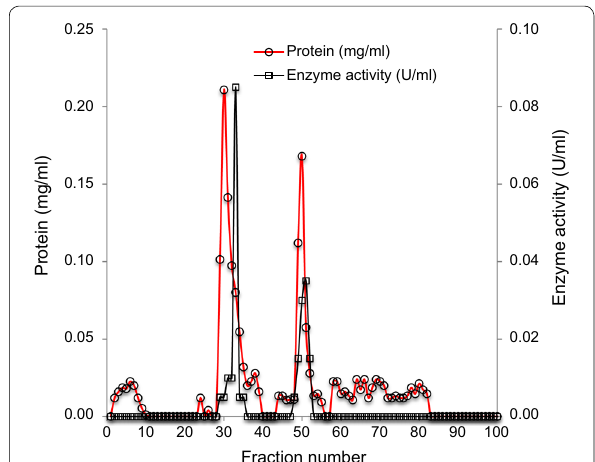
Fig. 1 Elution profile of lignin peroxidase by DEAE-cellulose ion exchange chromatography